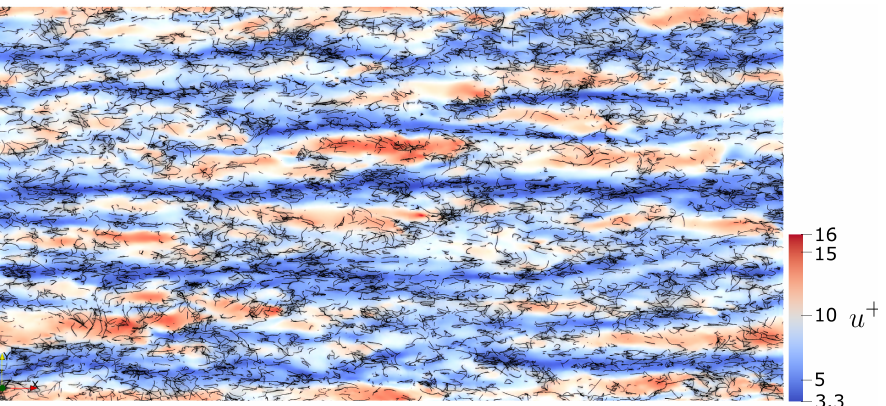
= 1.3, φ = 2.12 · 10 − 4 . ρ